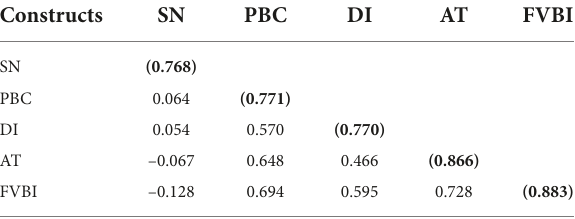
TABLE 4 The discriminatory validity test of variables.